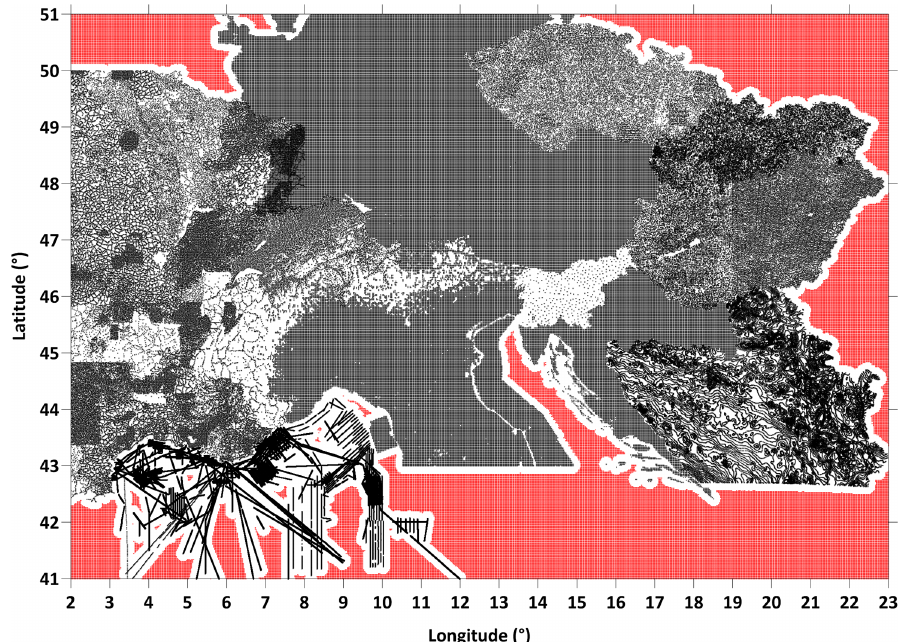
Figure 19. Despite all efforts to achieve the greatest possible homogeneity in the database and processing steps, this map is intended to show that the initial database was different due to national requirements. First, the outer areas shown in red are supplements/fillings with GGM values (Sect. 4.2). Irregular black dots indicate the use of point data, and in the offshore areas of the Ligurian Sea black lines indicate the ship tracks. In the southeast of the chart, isolines have been digitized (see also Sect.